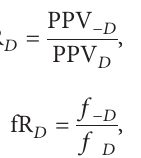
Figure 1: Example of Loss desirable reduction in Loss k